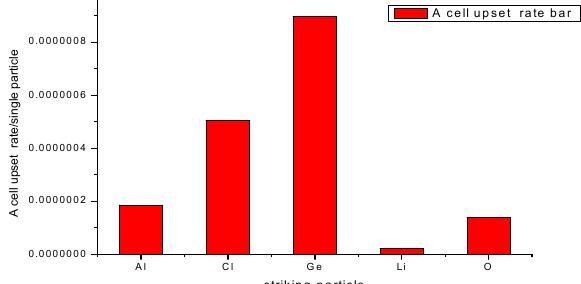
Figure 14. Single cell upsets (SCUs) versus particles for 512 Kbit SRAM with a 55AA pattern for normal incidence irradiation operated at 1.1 V.